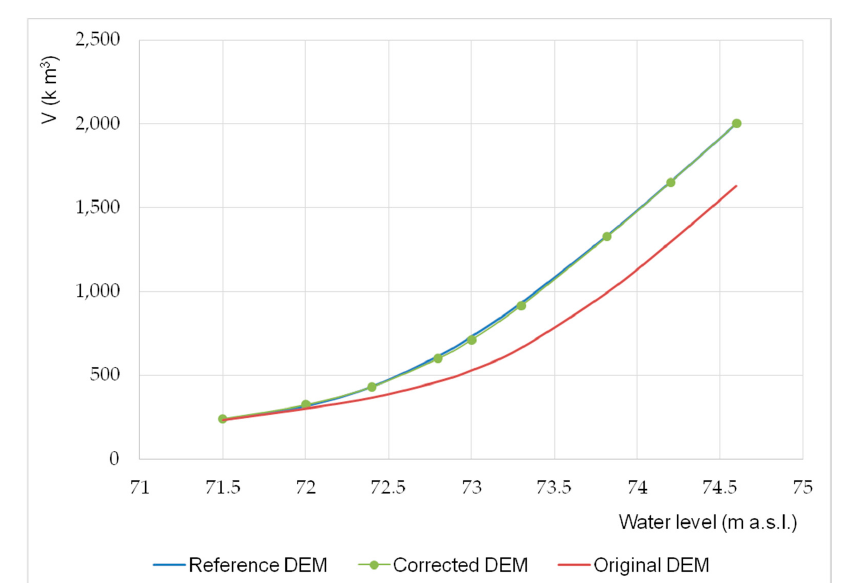
Figure 9. Comparison of the curves describing the relationship of the elevation of the water table at the cross-section 351.820 and the volume of accumulated water, calculated on the basis of the results of the 2D model.